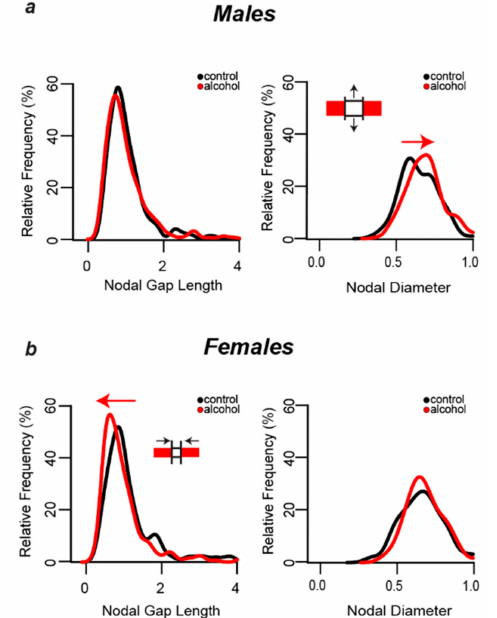
Figure 4. Sex-Dependent Changes in Nodal Dimensions. ( a ) Alcohol did not change the nodal gap length distribution in males, but it caused a shift towards larger axonal diameters (two-sample Kolmogorov–Smirnov test, p = 0.0004). ( b ) In contrast, alcohol shifted the nodal length distribution in females towards shorter nodes (two-sample Kolmogorov–Smirnov test, p = 0.0002), with no change in axon diameter